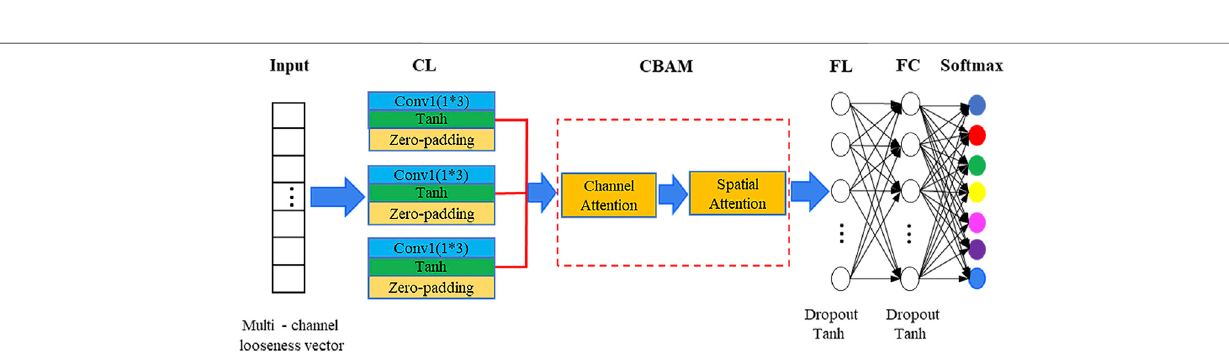
FIGURE 5 | Calculation principle of the convolution block attention module.